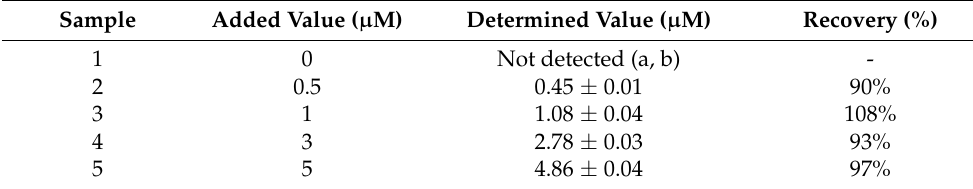
Table 1. Results of the recovery analysis of 4-BPA in apple sample ( n =